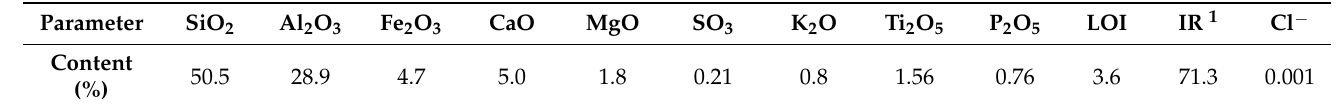
Table 5. Average chemical compositions of the tested coal fly ash